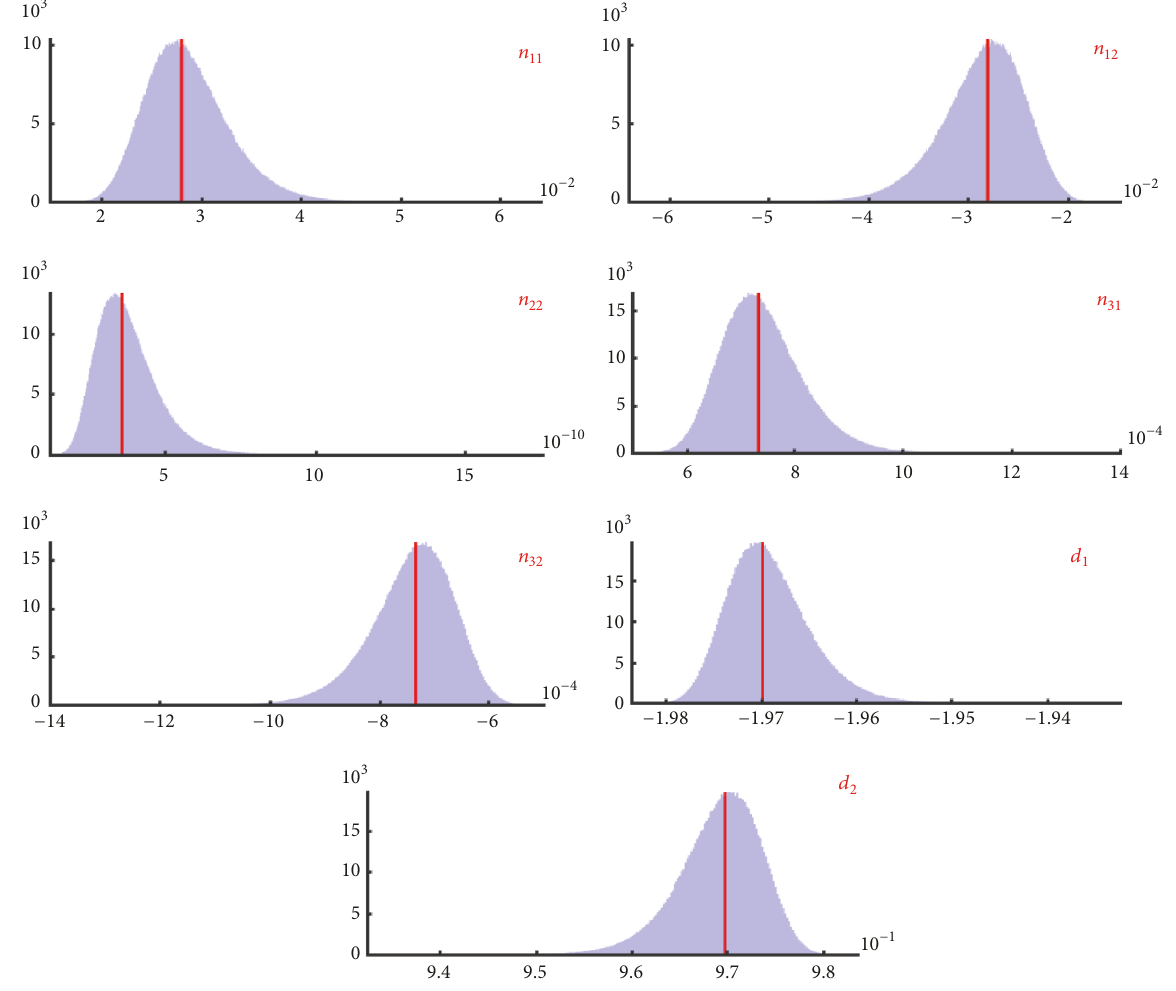
Figure 6: Histograms, RC to ARX transformation.